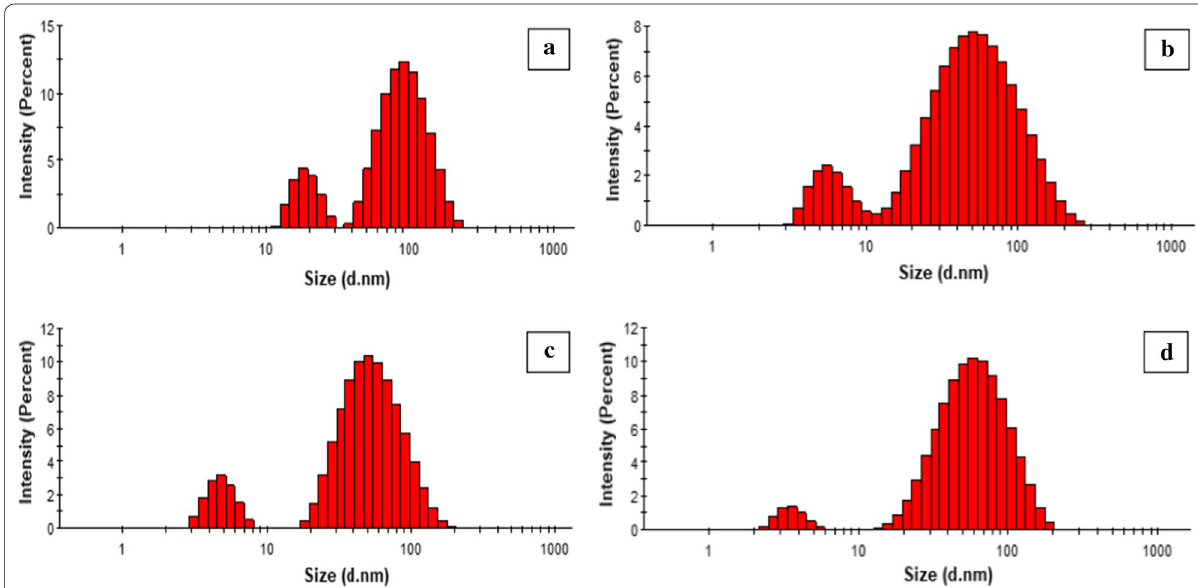
Fig. 4 DLS analysis of Ag NPs: Ag NPs 1 ( a ), Ag NPs 2 ( b ), Ag NPs 3 ( c ) and Ag NPs 4 ( d ). See the